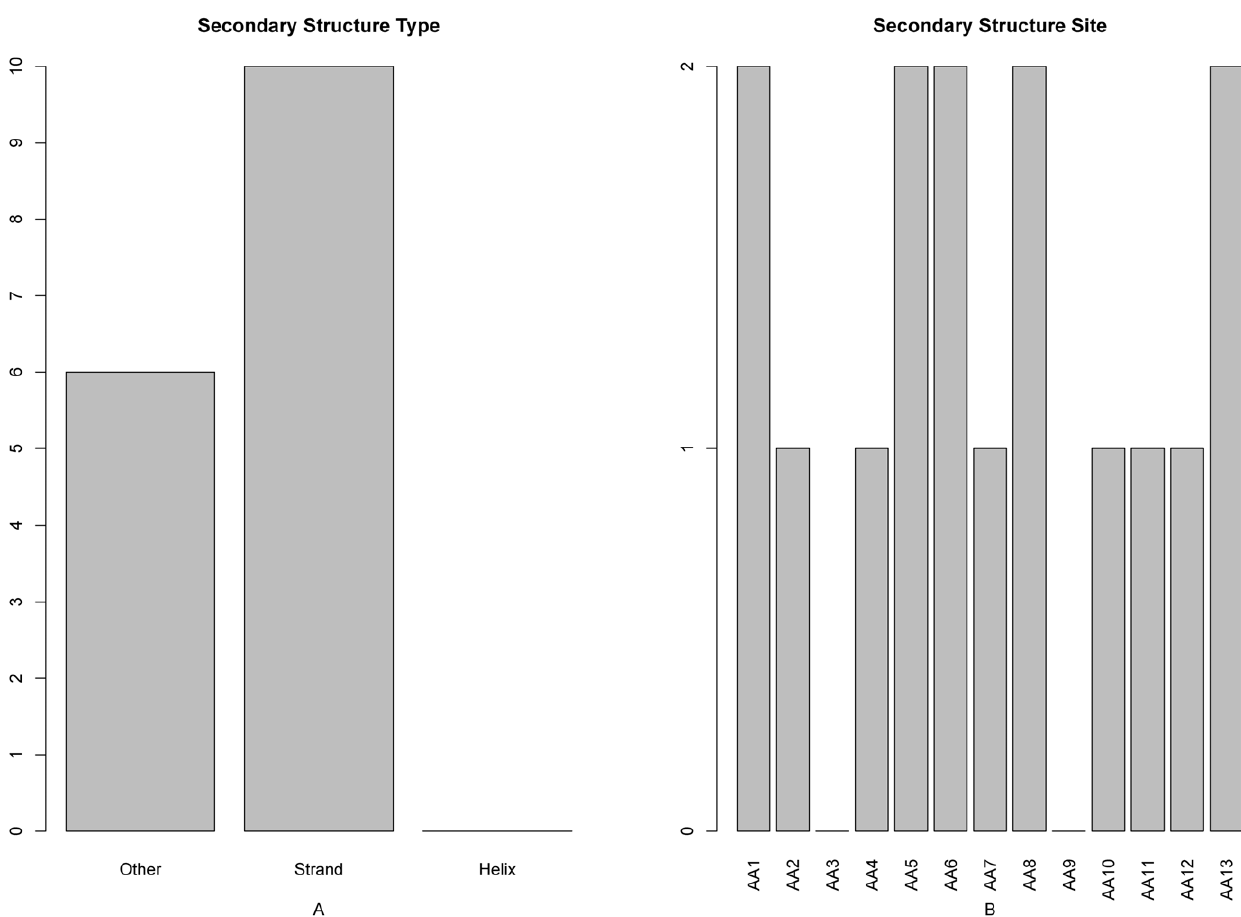
Figure 6. A 2-dimensional histogram to characterize the secondary structure types in the final optimal features set. The impact on the domain prediction from ( A ) the three different secondary structure types, and ( B ) each of the 13 subsites. See the text for further explanation. See the text for further explanation.